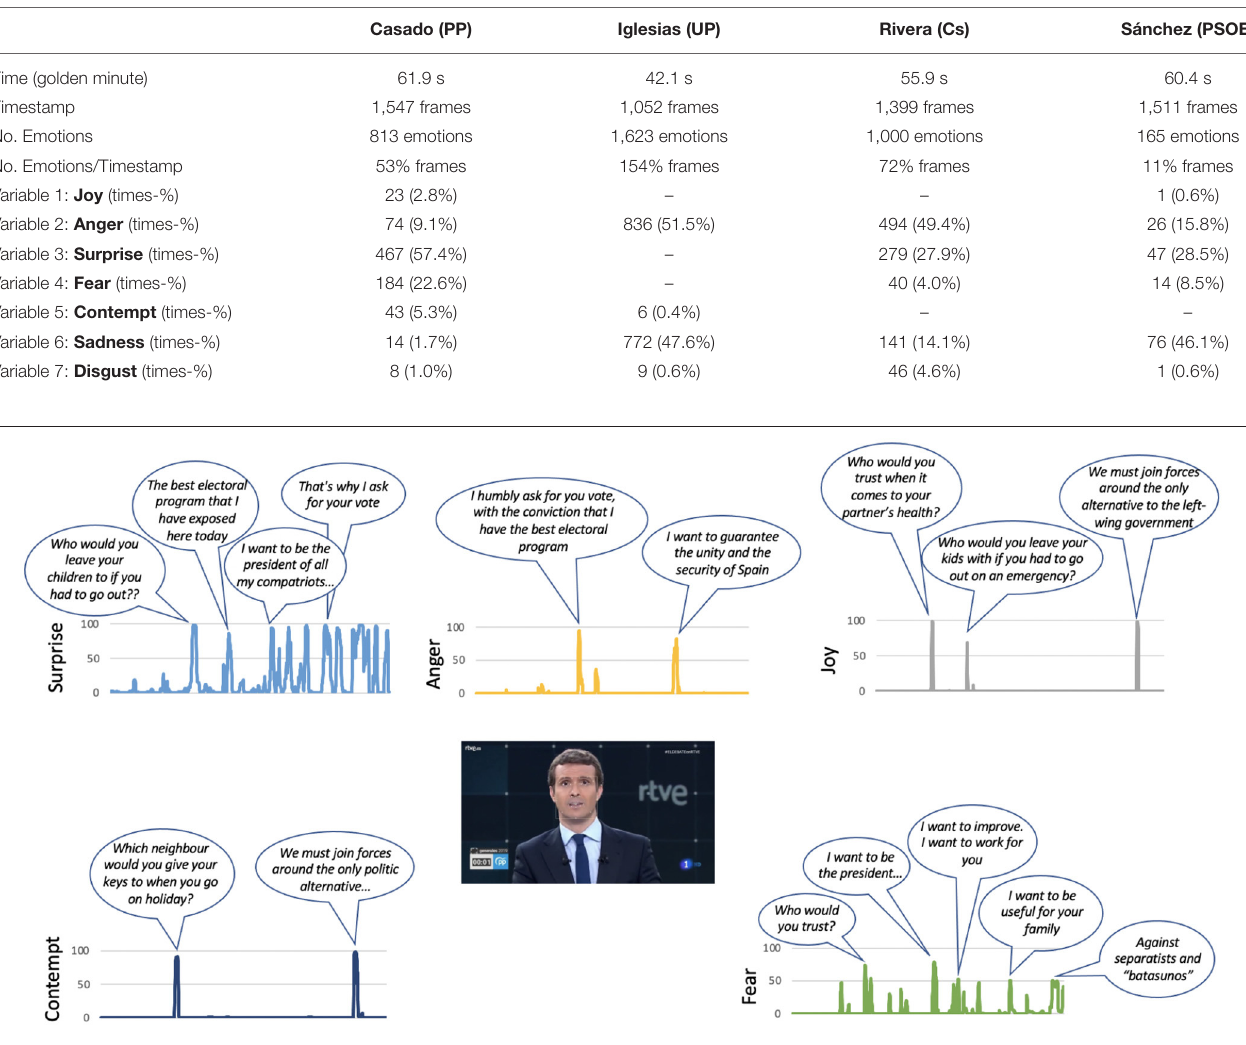
TABLE 2 | Descriptive analysis about the timestamp and frequency of the emotions showed by each candidate. Casado (PP) Iglesias (UP) Rivera (Cs) Sánchez (PSOE)